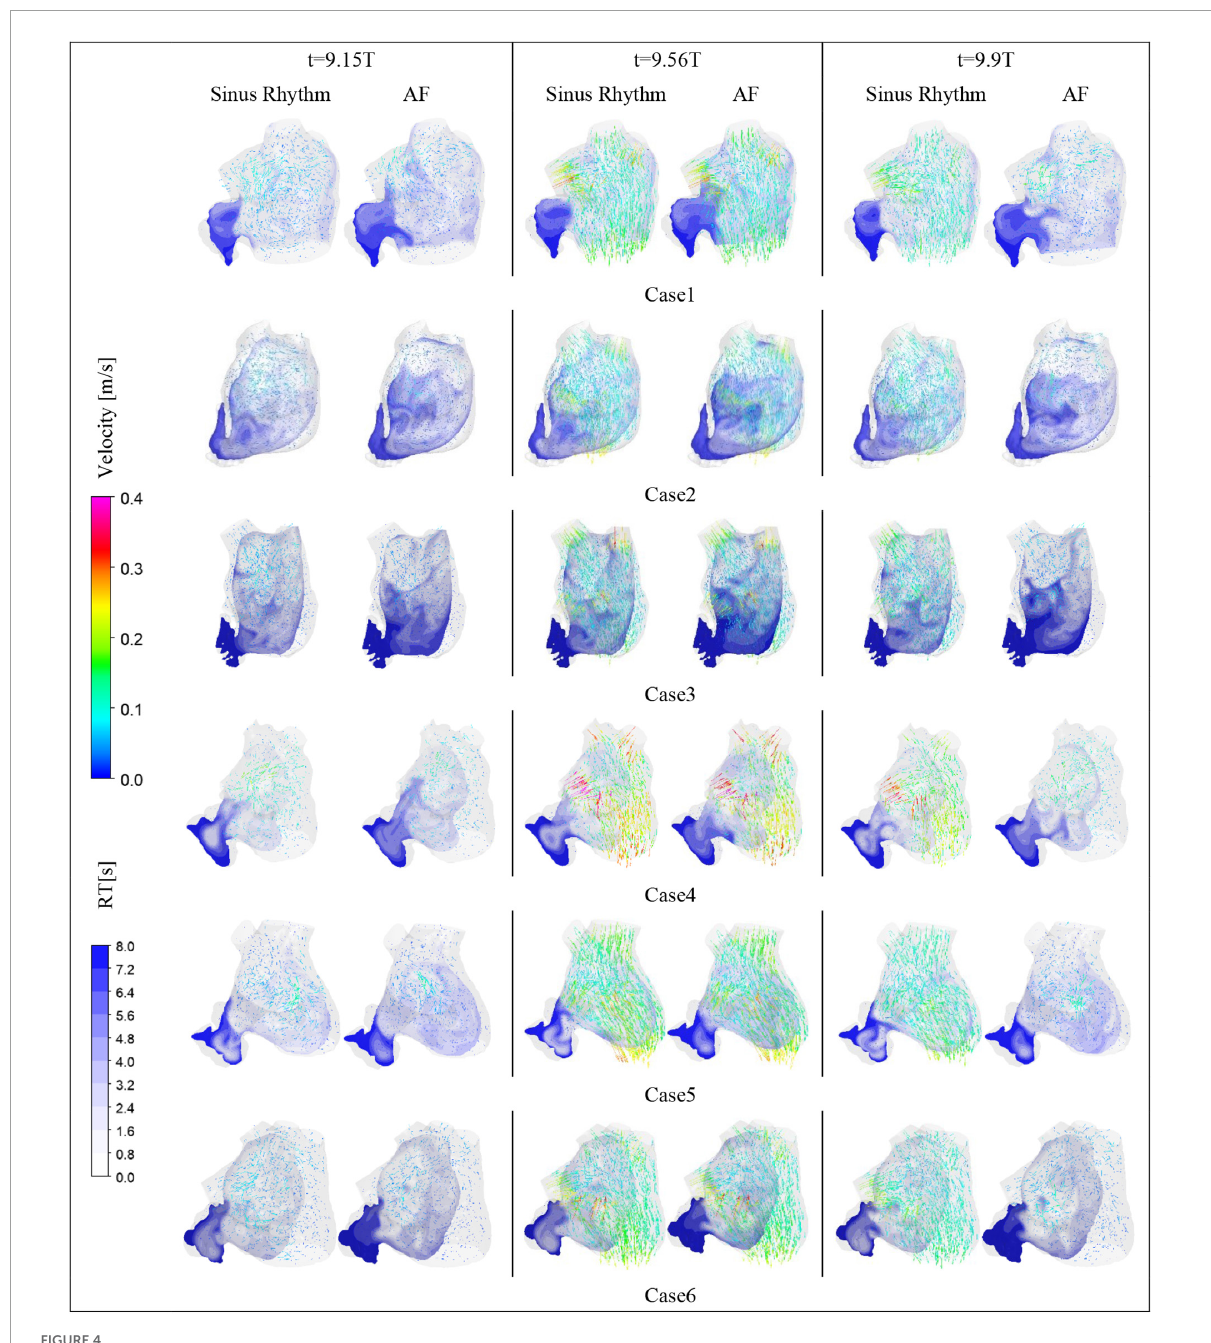
FIGURE4 The blood flow velocity in LA and the distribution of residence time in a